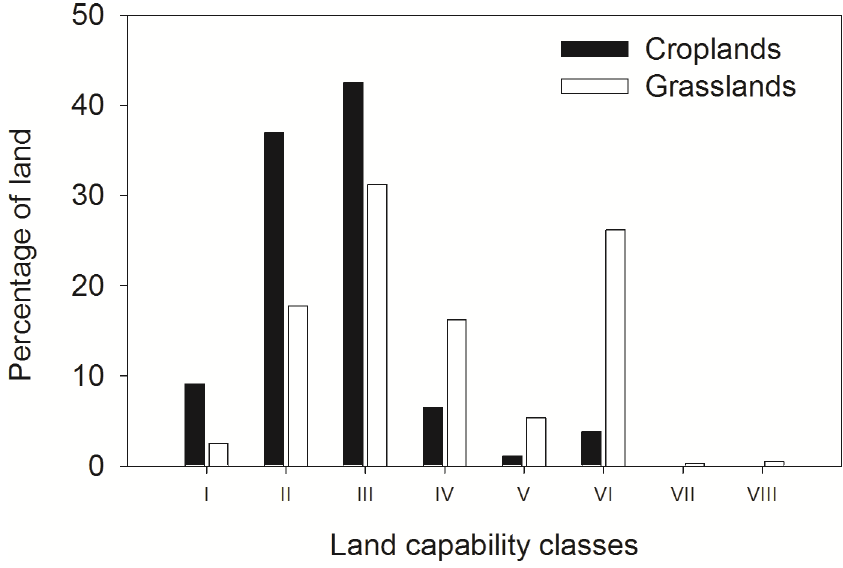
Fig 2. Percentages of croplands and grasslands in NRCS land capability classesI to